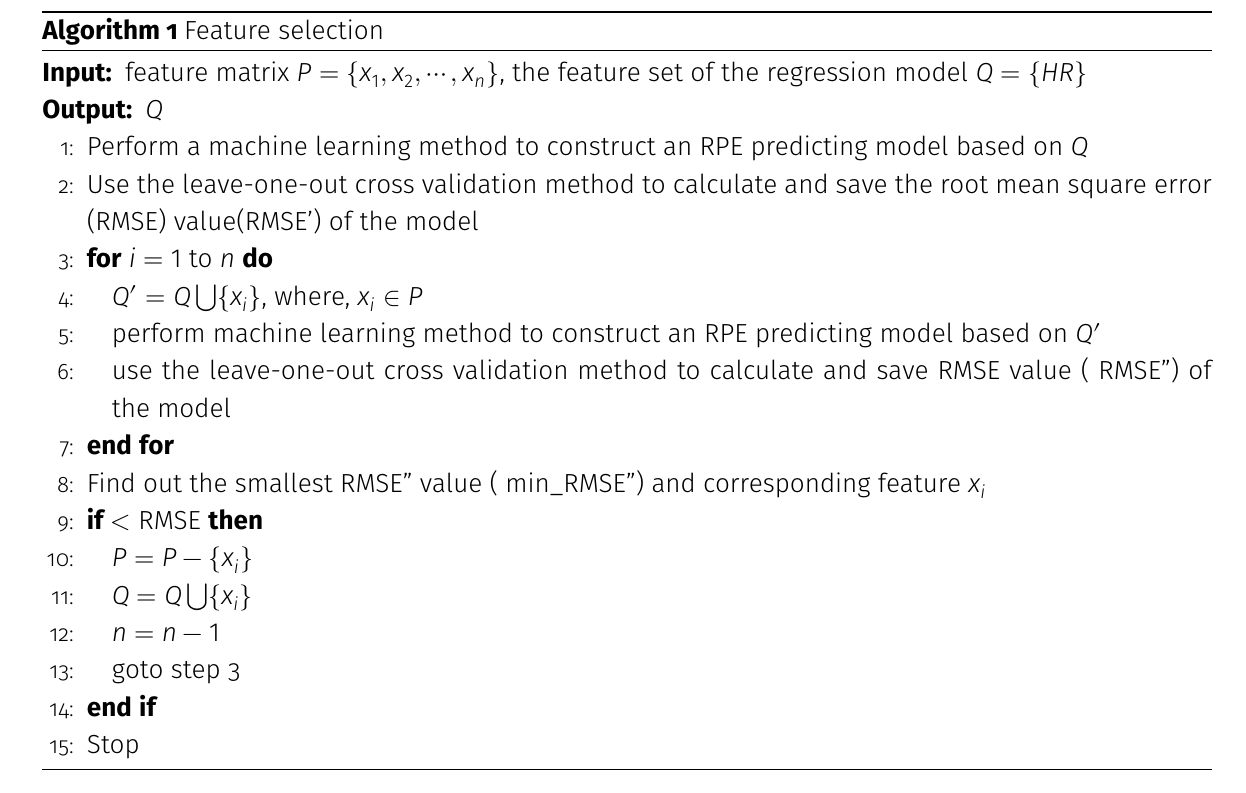
Algorithm 1 Feature